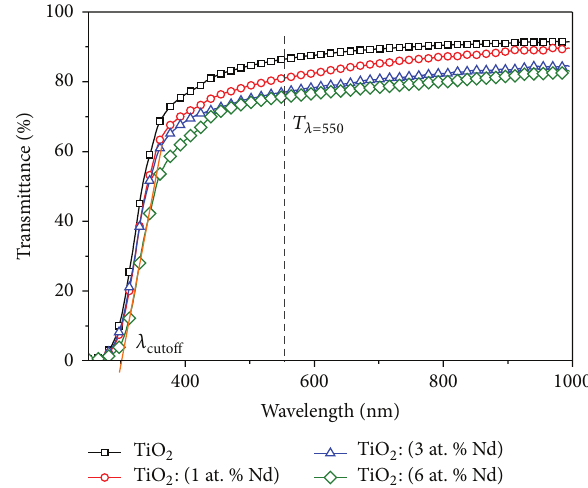
Figure 9: Transmittance spectra of TiO 2 and TiO 2 :Nd thin films prepared by spin-coating method.